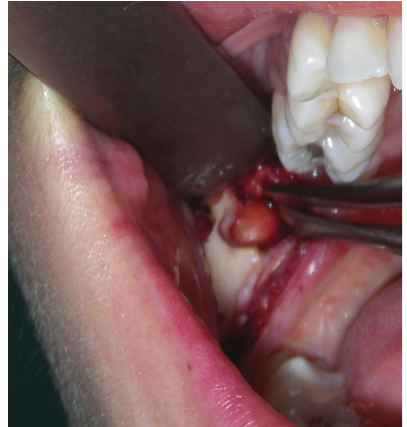
Figure 5: Intraoperative